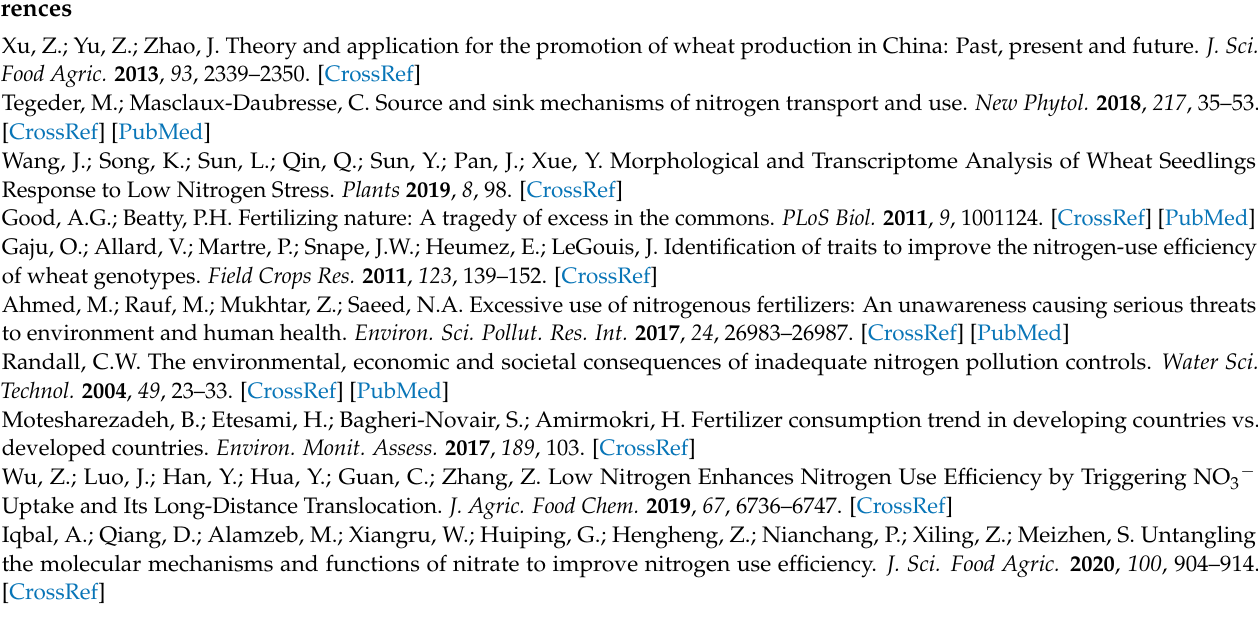
Figure S5: Scatter plot comparing the expression levels for the 4534 genes specifically expressed in the N0_1Y vs. N1_1Y comparison between N treatments in each wheat NIL; Figure S6: Scatter plot comparing the relative expression ratio for the 95 upregulated genes specifically expressed in the N0_1Y vs. N1_1Y comparison between wheat NILs under each N treatment; Figure S7: Scatter plot comparing the relative expression ratio for the 93 downregulated genes specifically expressed in the N0_1Y vs. N1_1Y comparison between wheat NILs under each N treatment; Figure S8: Comparison of GO classifications of DEGs between the two wheat NILs; Figure S9: Validation of 12 potential DEGs identified from transcriptome analysis by qRT-PCR; Figure S10: Gene expression correlation between the qRT-PCR and RNA-seq data. Table S1: Primer sequences used in this study; Table S2: Analysis of the DEGs in pairwise comparisons; Table S3: GO enrichment analysis of genes in pairwise comparisons; Table S4: Classification of N-Responsive Genes in 1Y revealed different responses to N-deficit conditions; Table S5: Category of N-Responsive Genes in 1W showed different responses to N